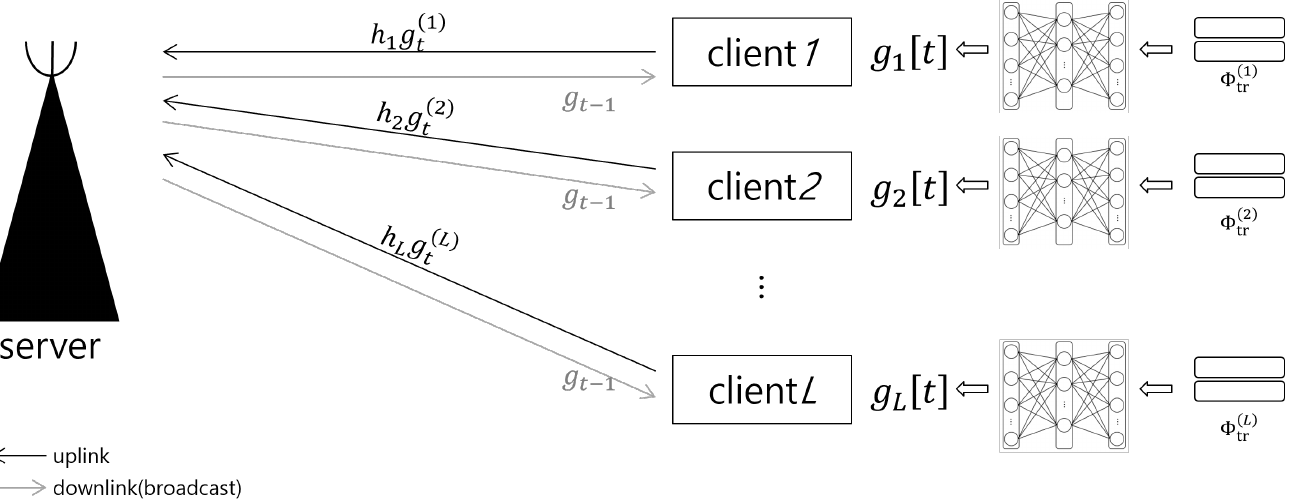
Figure 1. Federated Learning over wireless communication system for target